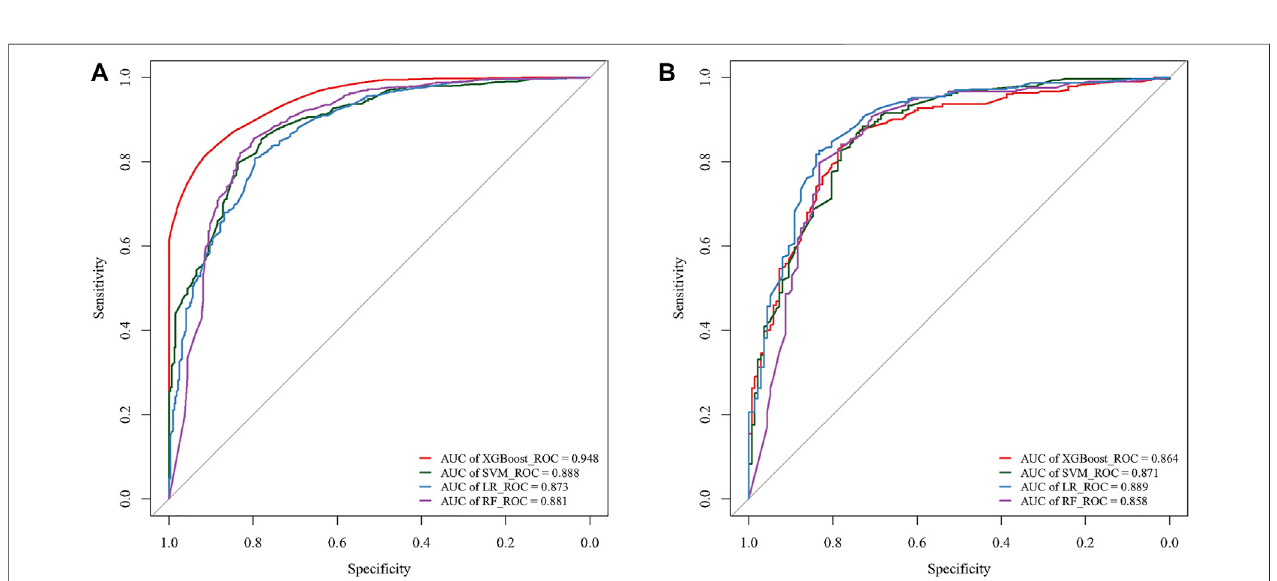
FIGURE 4 | ROC curves of the models for the training (A) and test (B) cohorts.